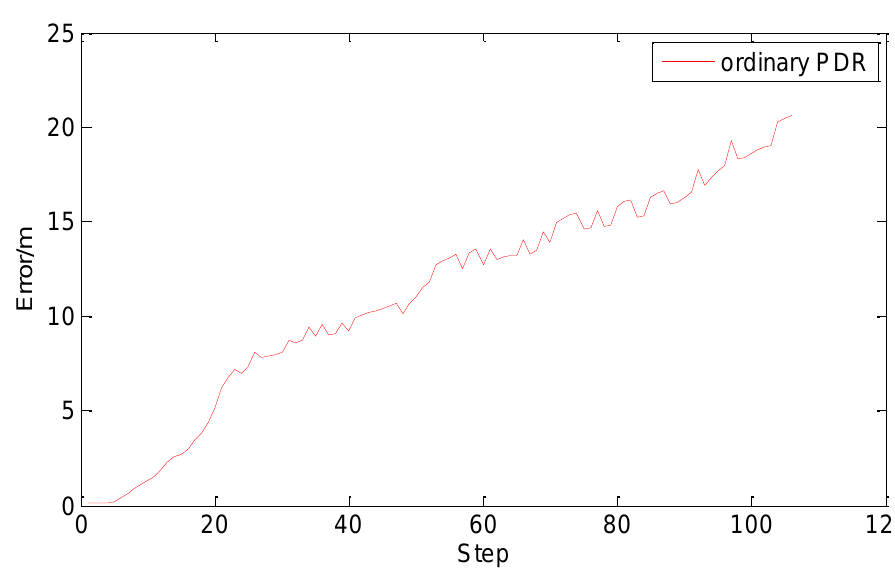
Figure 15. The accumulated error of the PDR